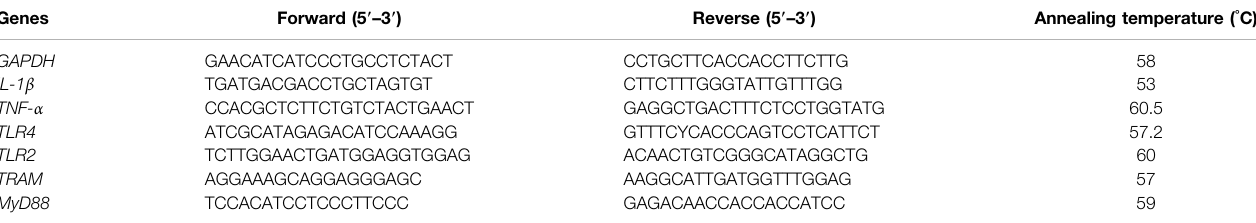
TABLE 1 | Primer sequences for